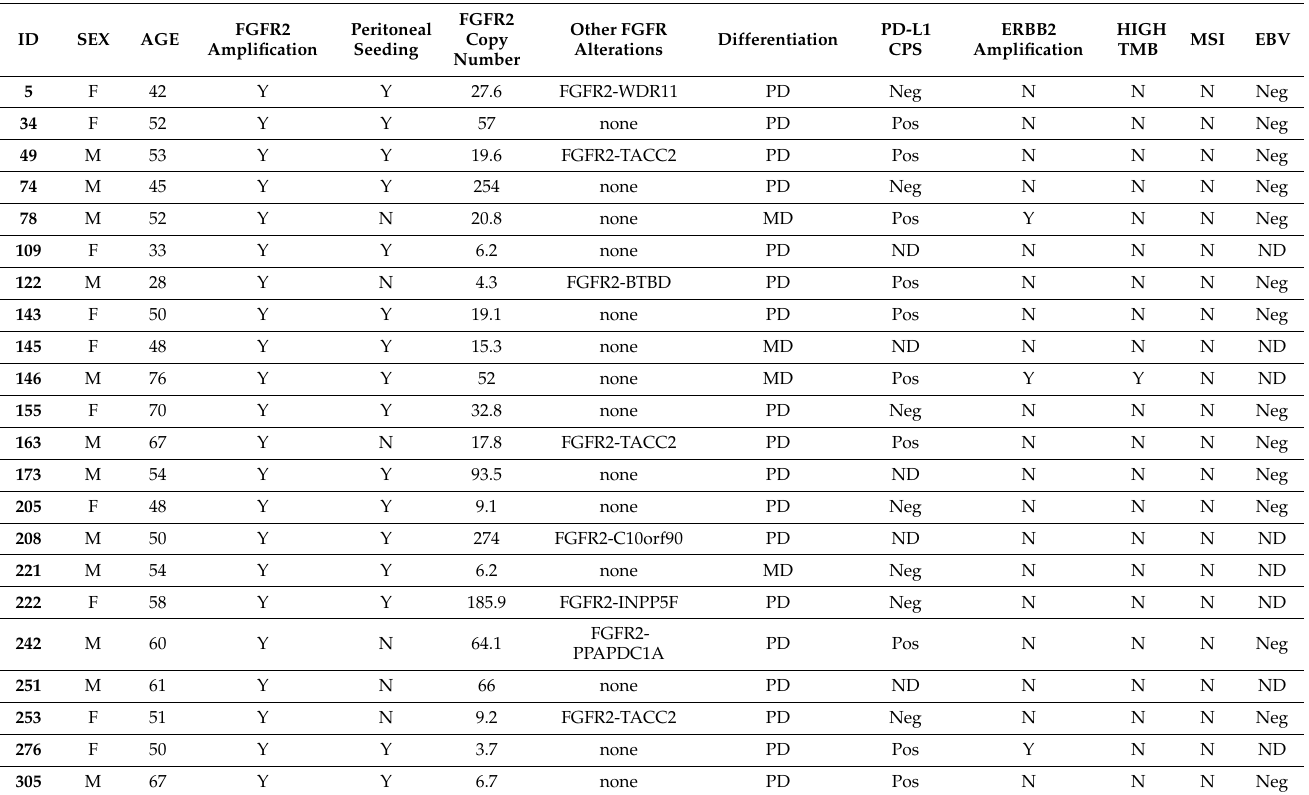
Table 2. Clinicopathological information of 26 patients with FGFR-altered gastric